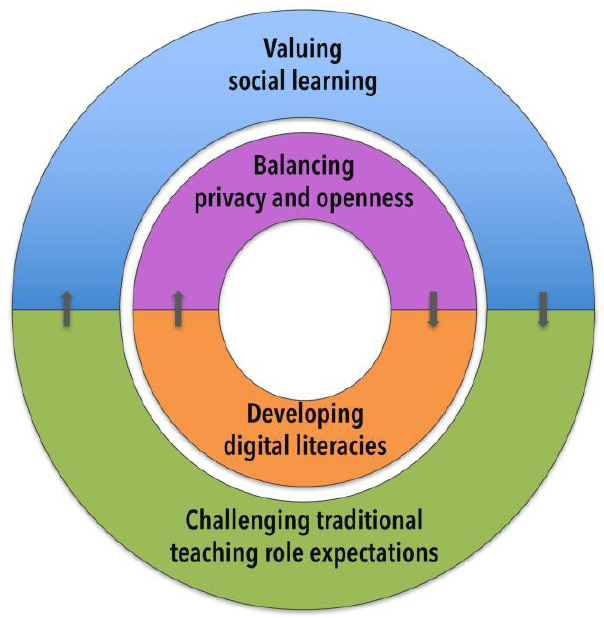
Figure 1 . Four dimensions shared by educators using